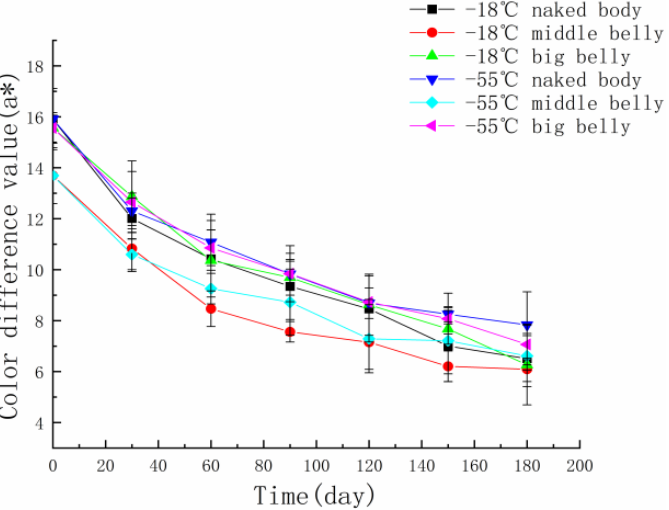
Figure 2. The color change in different parts of tuna during frozen storage at different temperatures.